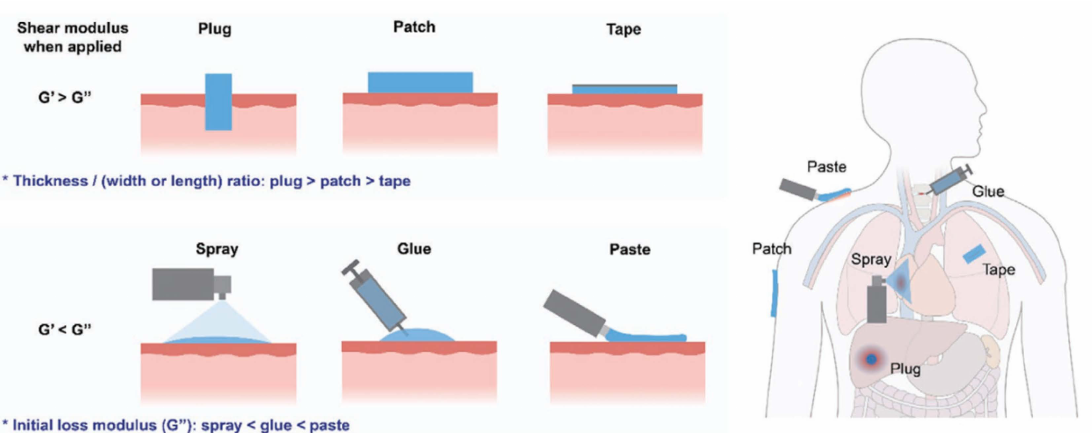
Figure 1. Delivery approaches and physical forms of adhesive materials. Examples show that the various forms of adhesives can be used in different tissues or organs. Reproduced with permission [7]. Copyright 2021, John Wiley and